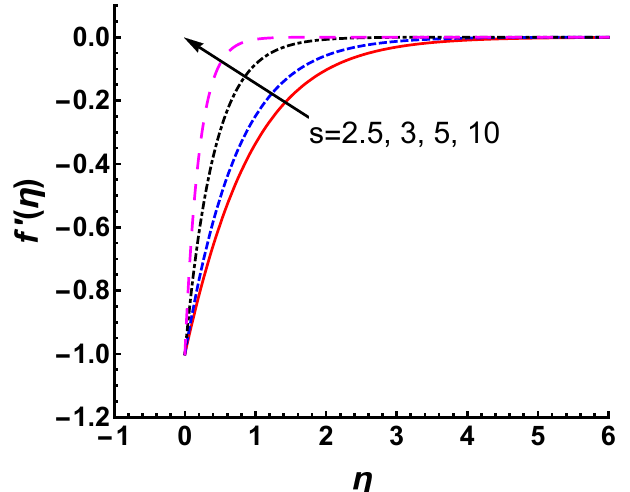
Figure 9. Velocity profile f (cid:48) ( η ) for different values of s with γ = M = 1 and Pr = 0.71.